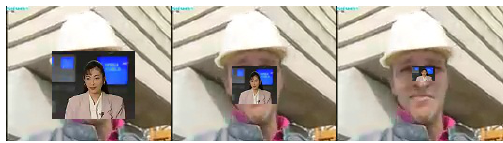
Figure 10. Foreman-Akiyo Picture in picture attack using a factor (from left to right 1/4, 1/16, 1/64)